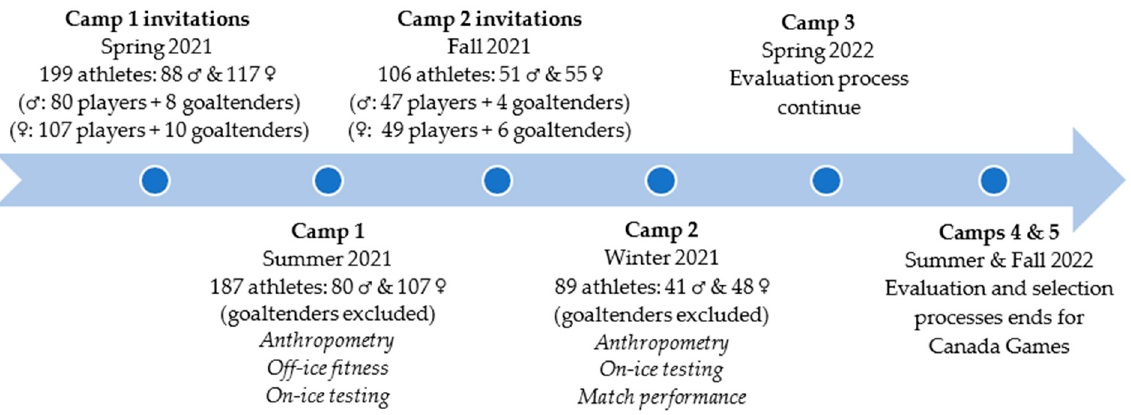
Figure 1. Schedule timeline of Hockey Quebec selection process, and assessment fields during Camps 1 and 2.